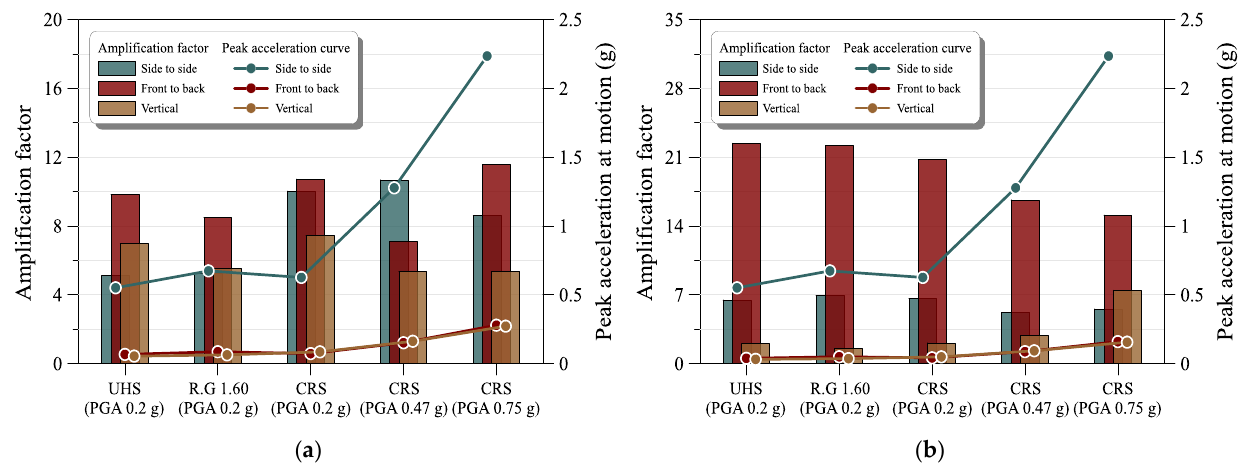
Figure 14. Relationships of amplification and peak acceleration based on input motion: ( a ) A7 and ( b )